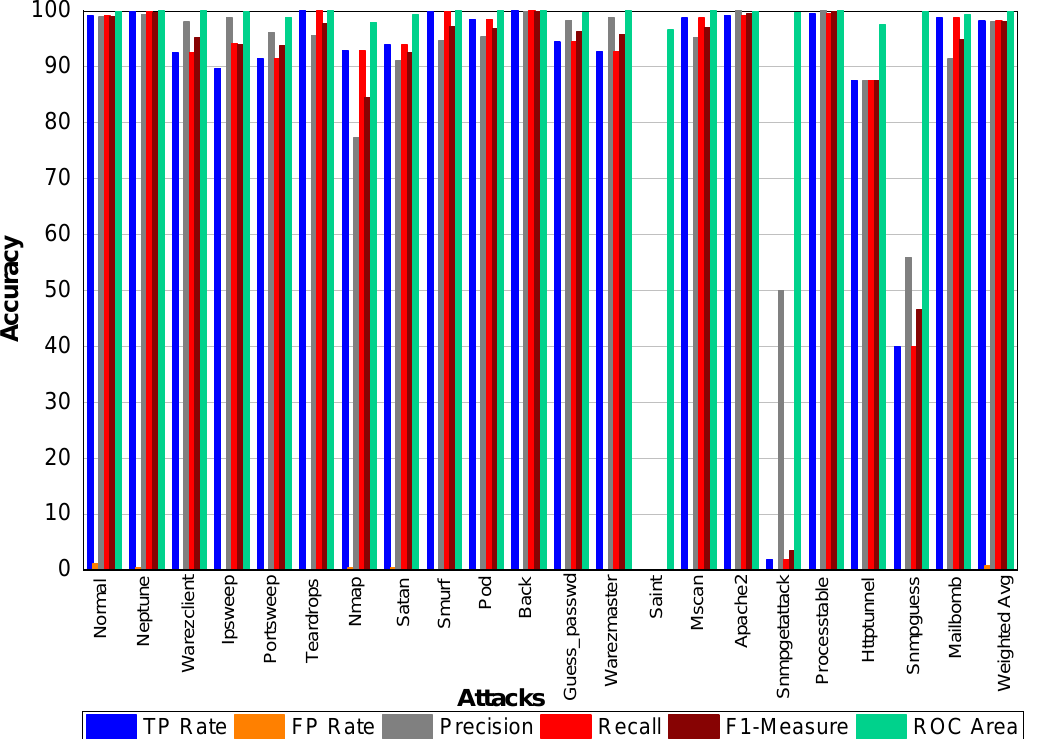
Figure 3. Classification report for the Adaboost J48 KDD99